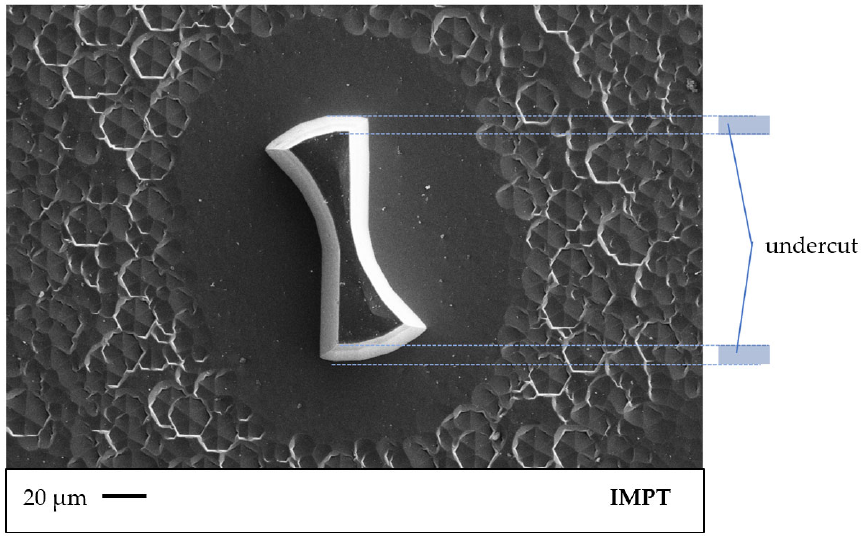
Figure 6. Underestimation of the structures; marked in blue is the effect of isotropy.